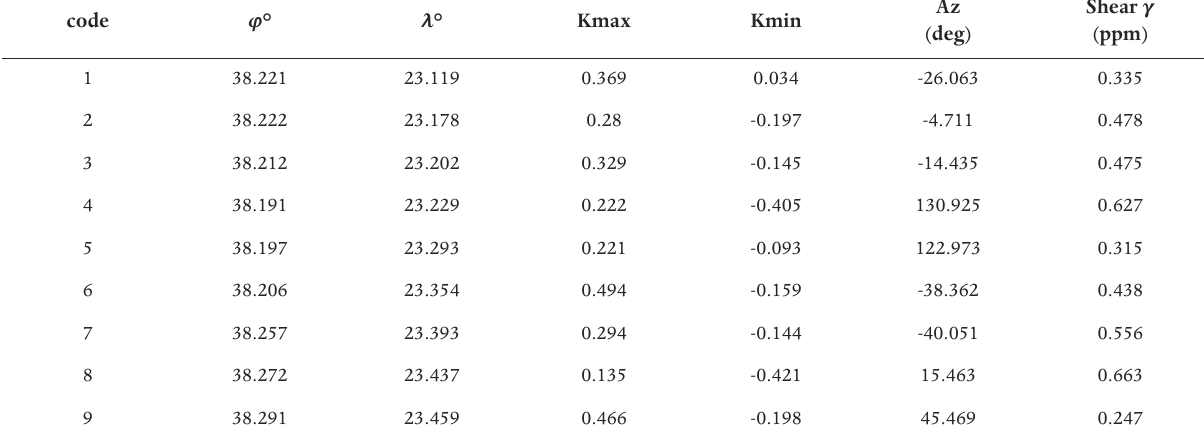
Table 3. Strain parameters of the Kaparelli region using tectonic velocities from triangles of GPS sites. Geographic coordinates refer to tri- angle centroids.